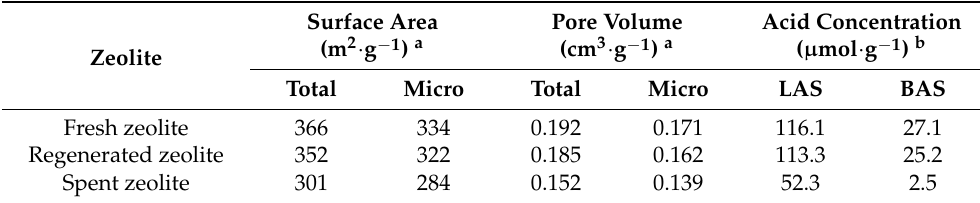
Table 4. Textural properties of the